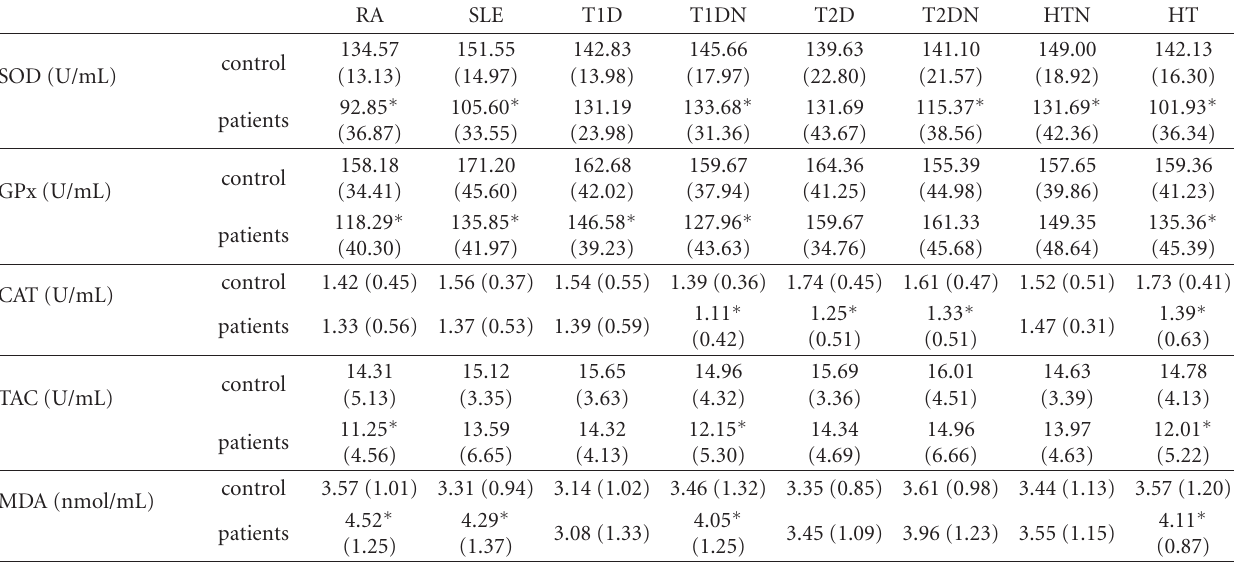
Table 3: The antioxidant enzyme activity and MDA of subjects (mean